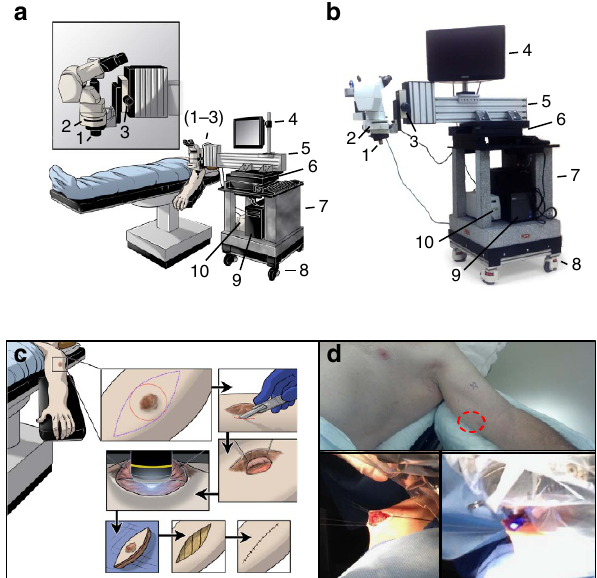
Figure 1 | Design of a portable intraoperative IVM system and surgical exposure of tumour microvasculature. ( a ) Schematic and ( b ) photograph of the intravital microscopy unit designed as a mobile system for observations in the OR. Critical systems allowing for stable epifluorescence observation of patient tumours in real-time are highlighted as follows: